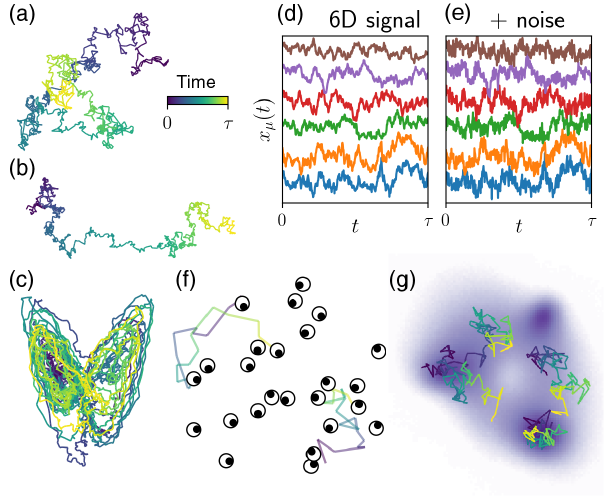
FIG. 1. Typical trajectories of example Brownian systems studied in this article. (a) Pure Brownian motion in 2D without forces. (b) A drifted Brownian motion trajectory. (c) The sto- chastic Lorenz process (see Fig. 5). (d) Time series of a 6D out- of-equilibrium Ornstein-Uhlenbeck process (see Fig. 4). (e) The same trajectories as in (d), with additional time-uncorrelated measurement noise. (f) Self-propelled active Brownian particles with soft repulsion and harmonic confinement (see Fig. 7). (g) Simulated single-molecule trajectories in a complex environ- ment with space-dependent diffusion (see Fig.